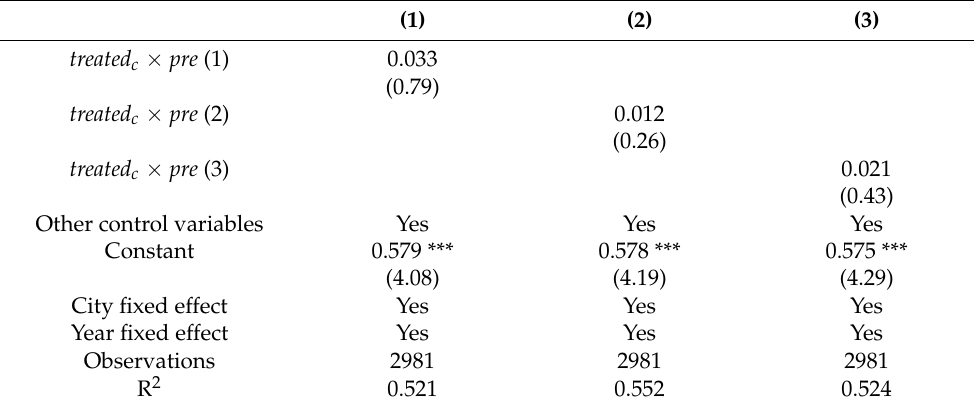
Table 5. Estimation results of counterfactual